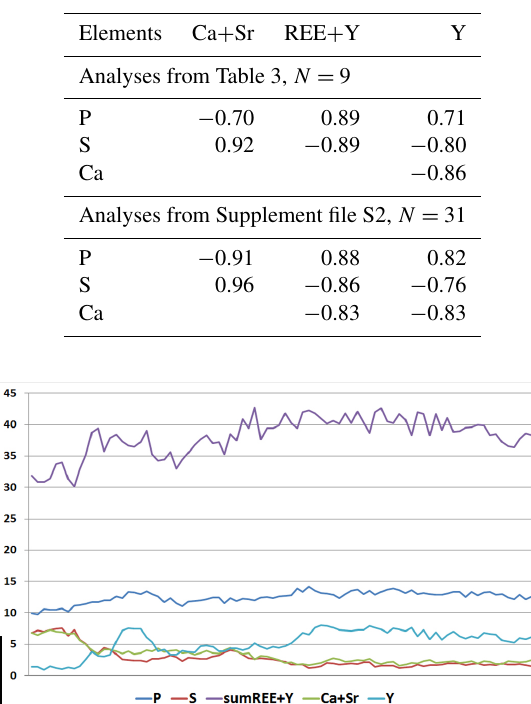
Table 4. Paired correlation coefficients of main elements of rhabdo- phane.